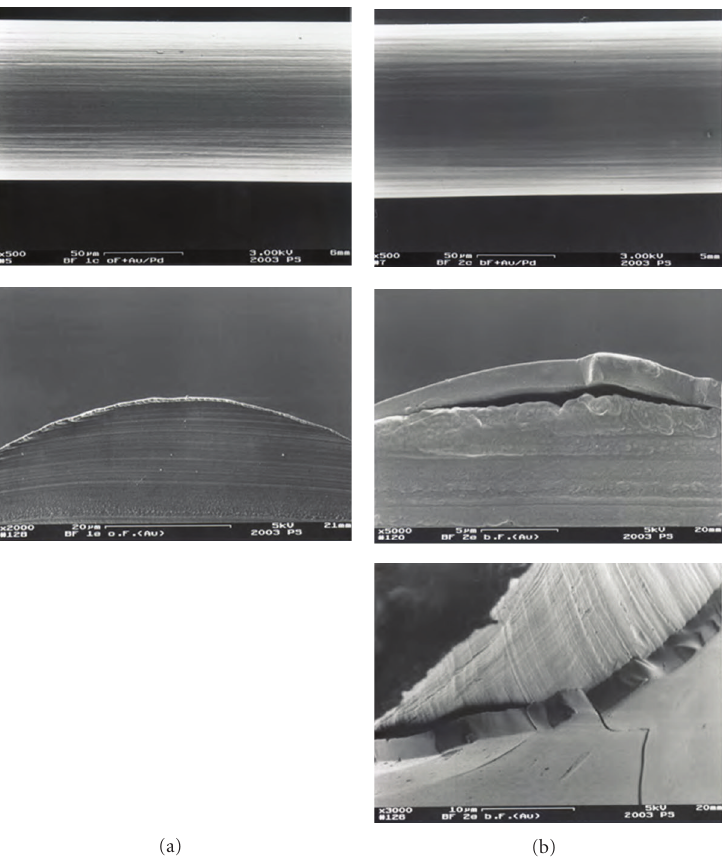
Figure 1: SEM images of uncoated (a) and coated (b) monofilament sutures. The coating forms an smooth even layer of 10 μ m thickness in which growth factors can be incorporated . In vivo the PDLLA coating is hydrolyzed and the growth factors are released in their biological active